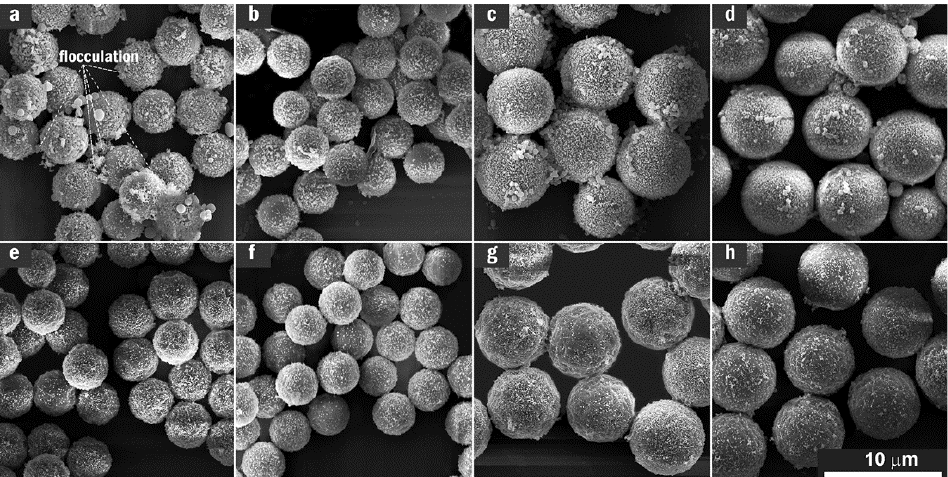
Figure 2. Impact of the acetic acid treatment on SEM images of AgNP/MF n substrate: ( a ) AgNP/MF 2 , ( b ) AgNP/MF 3 , ( c ) AgNP/MF 6 and ( d ) AgNP/MF 9 at the top were collected on the